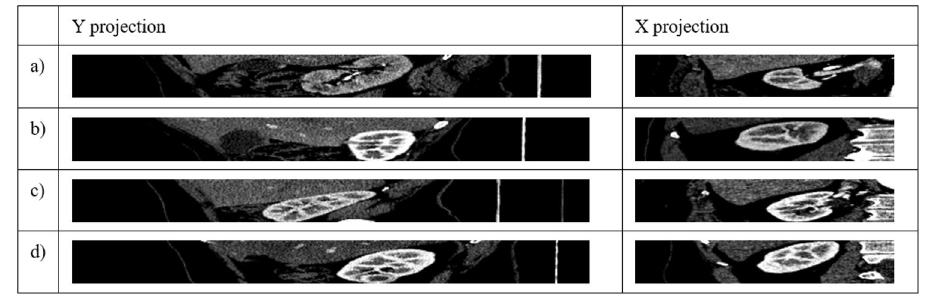
Figure 8. Example of four random images in X and Y projection for OC, resulting from point generation.